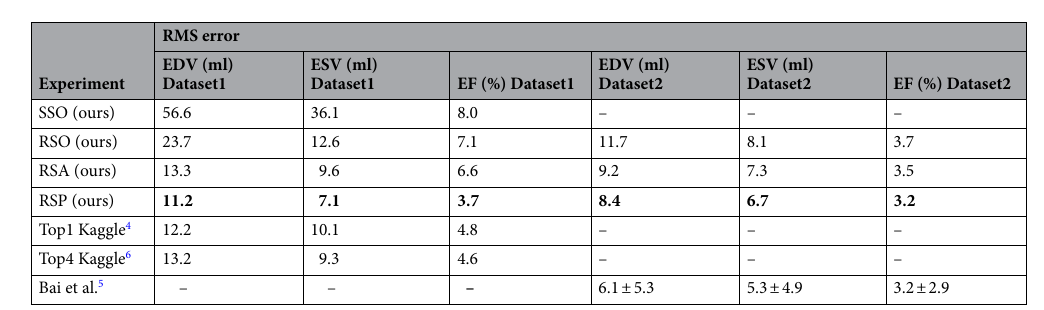
Table 1. RMSE ± SD for the EDV, ESV and EF prediction from top to bottom for our models trained on synthetic subjects only (SSO), real subjects only (RSO), real subjects all (RSA) experiment which means trained on all real subjects from combined datasets and SSO model finetuned on real cases is referred to as real subjects with pretraining (RSP). RSP Below are the results of the winner of the Kaggle challenge 4 (based on the mean CRPS 22 metric), the results of the top 4 team 6 (which had the lowest RMSE for EF in the competition), and previously reported results on the Dataset 2 5 for comparison. Significant values are in